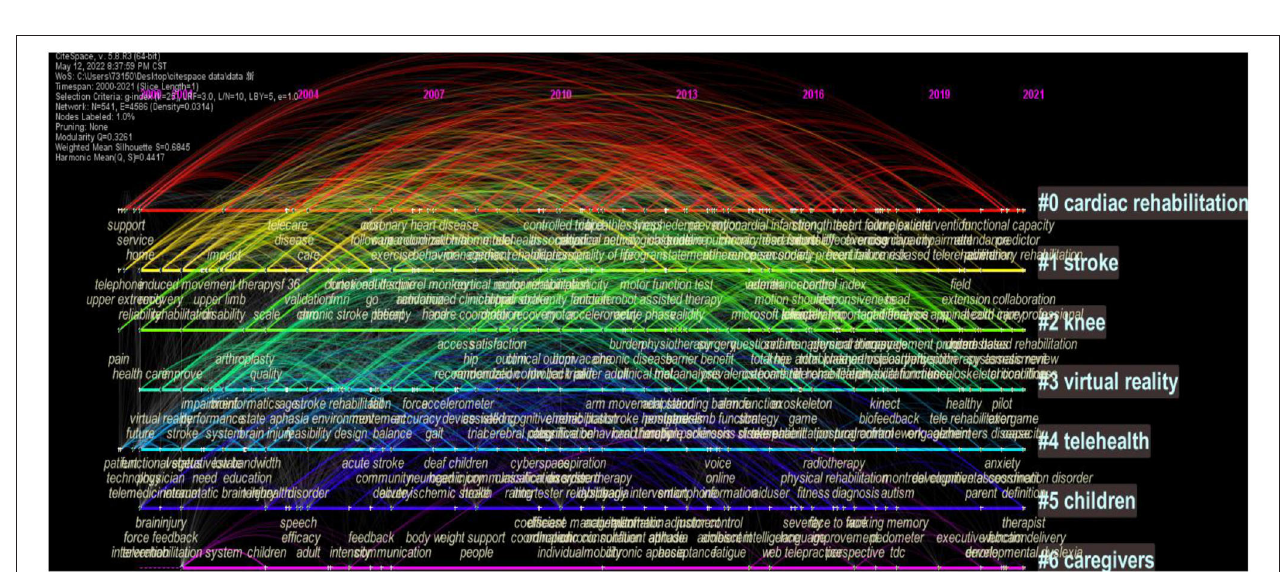
FIGURE 12 | The timeline view of keywords related to